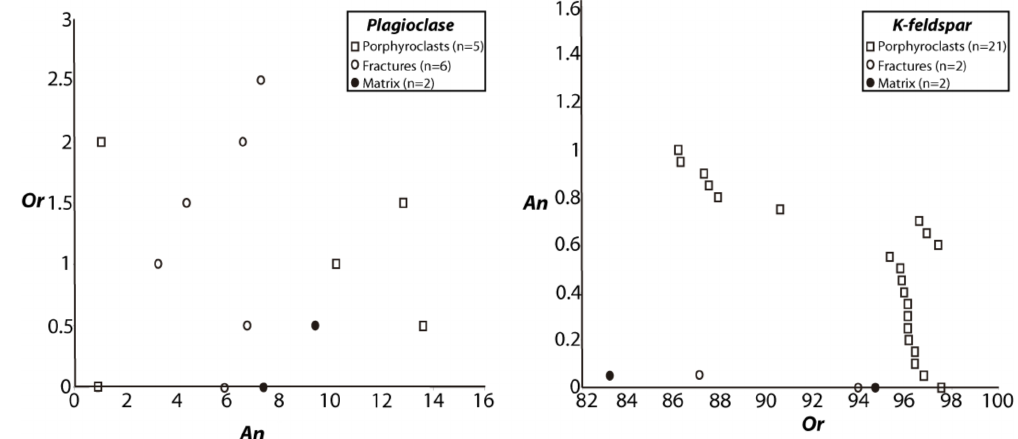
Figure 9. Chemical compositions of plagioclase and K-feldspar in the porphyroclasts and as recrystallized grains inside fractures and in the matrix.